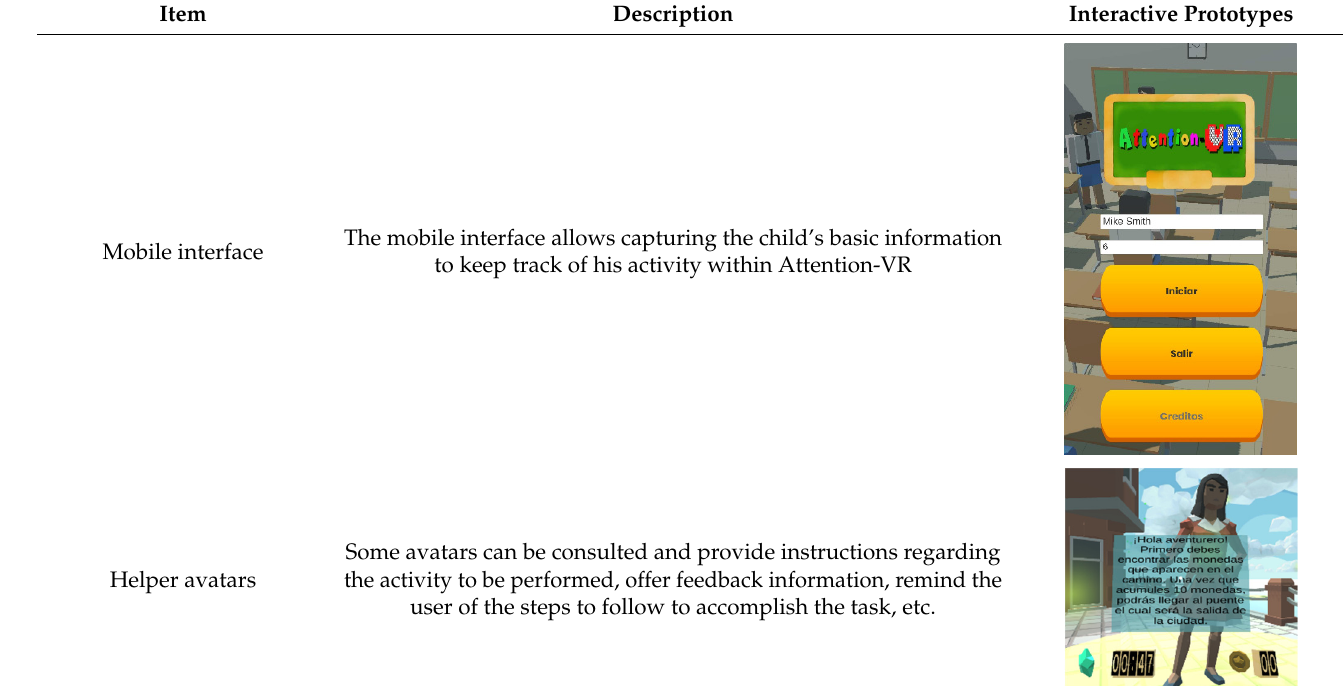
Table 5. Interactive prototypes for the virtual environment Attention-VR.